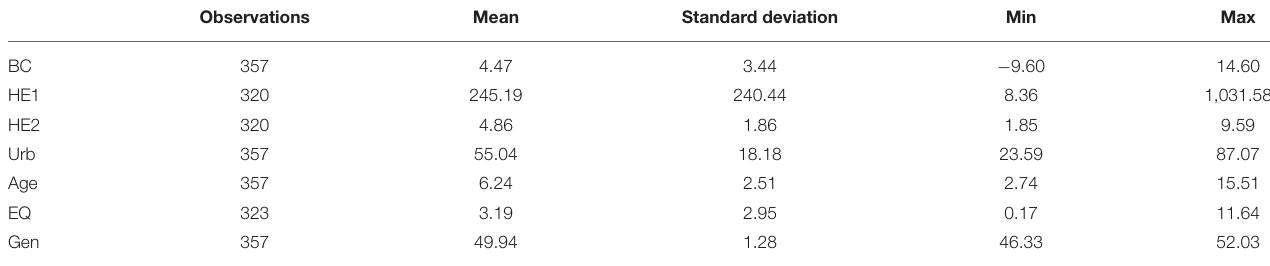
TABLE 3 | Summary statistics.